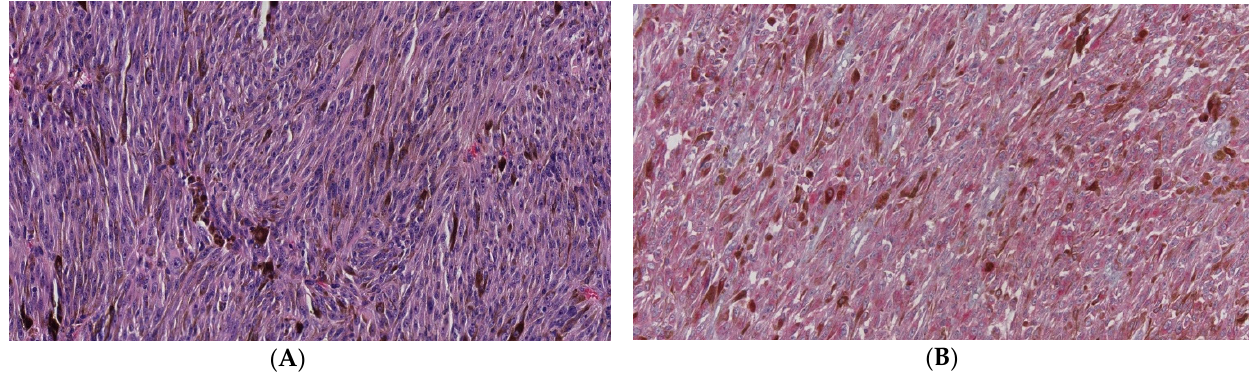
Figure 4. Uveal melanoma sample. ( A ) H&E image (×200). ( B ) Grade 0 of nuclear BAP1 staining with grade 3 of cytoplasmic BAP1 staining (×200).